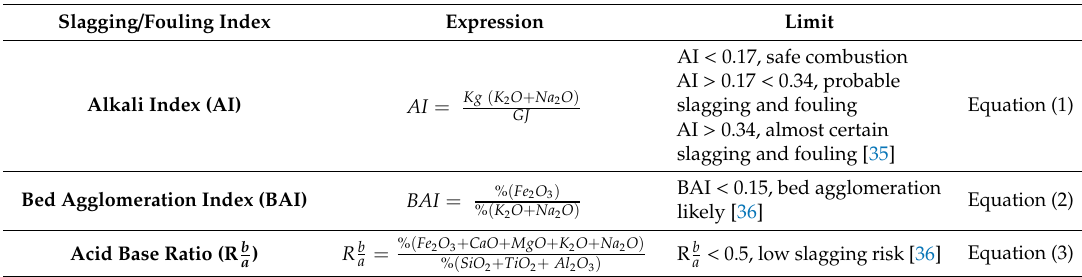
Table 1. Predictive slagging and fouling indices.